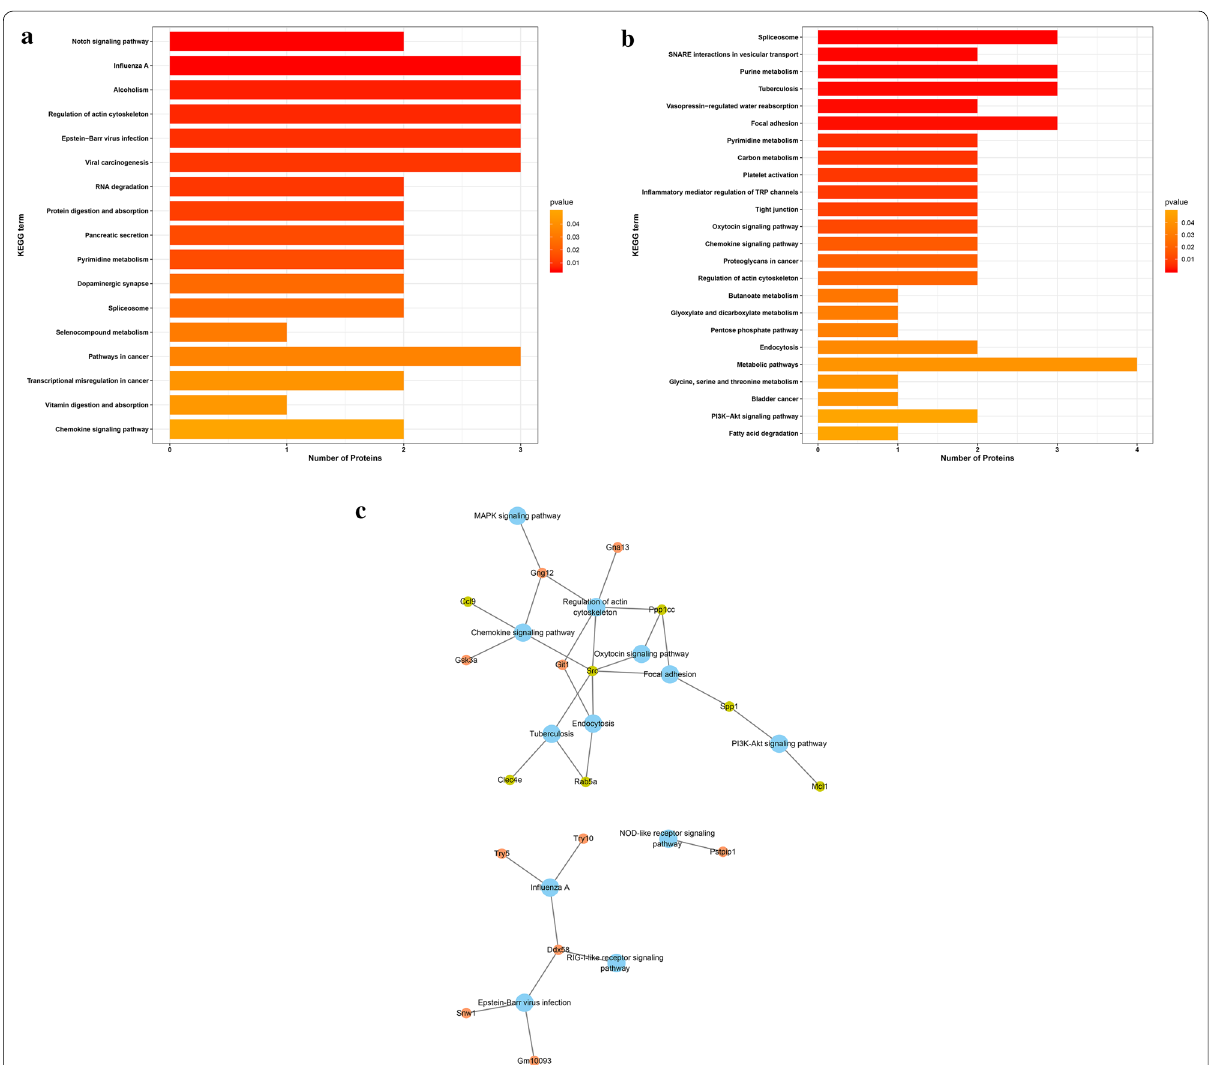
Fig. 3 KEGG pathway analysis. a KEGG enrichment analysis of upregulated proteins. b KEGG enrichment analysis of downregulated proteins. c Network of immunity related KEGG